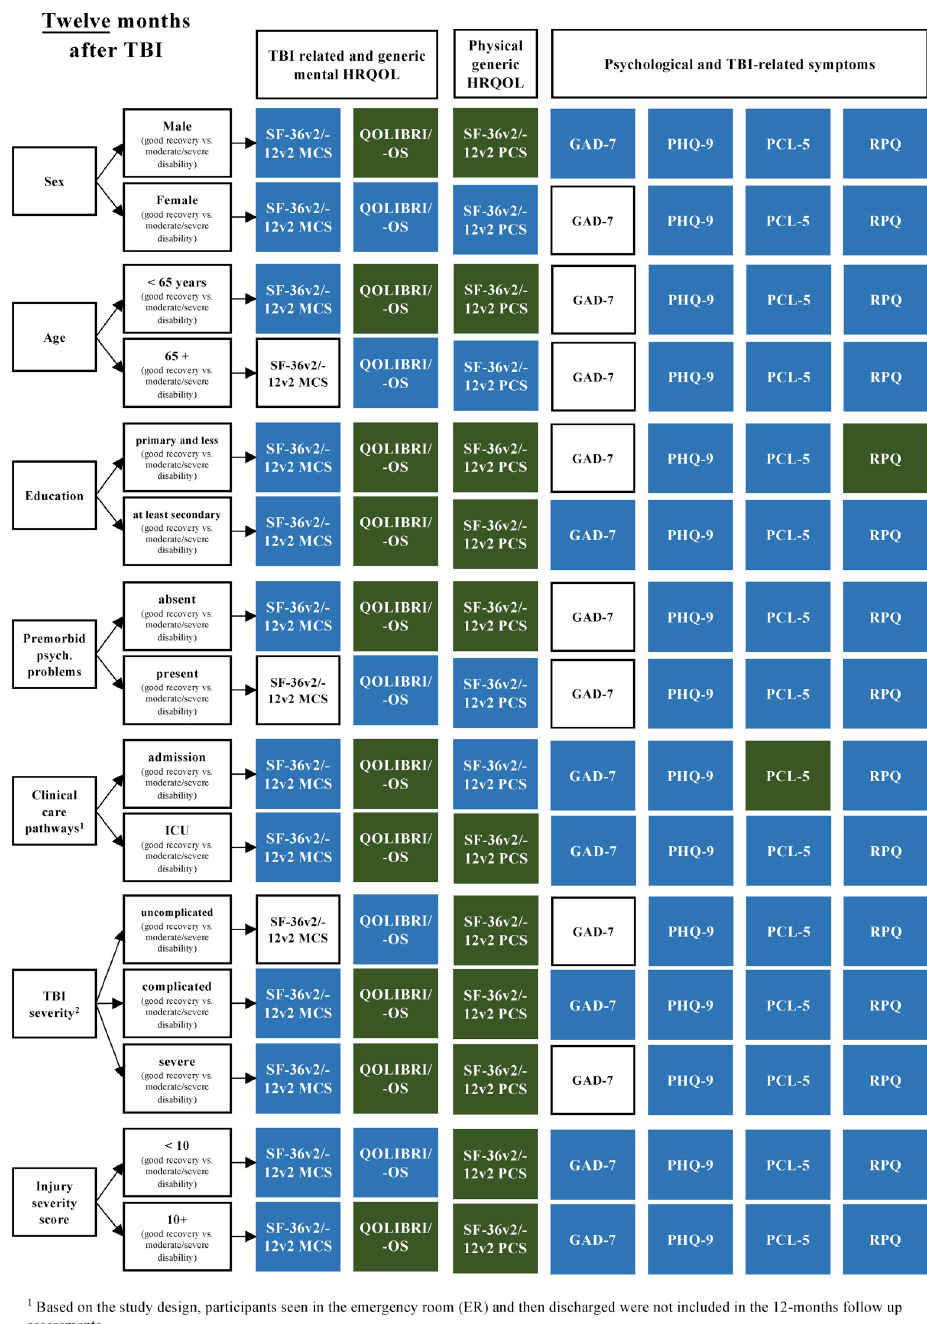
Fig 6. PROMs recommended for use with respect to different sociodemographic, premorbid, and injury-related patient groups and recovery statuses (i.e., GOSE/-Q as reference) at six months after TBI based on the MW effect sizes. Numbers are documented in S7 Table (data as available) and in S8 Table (completers).